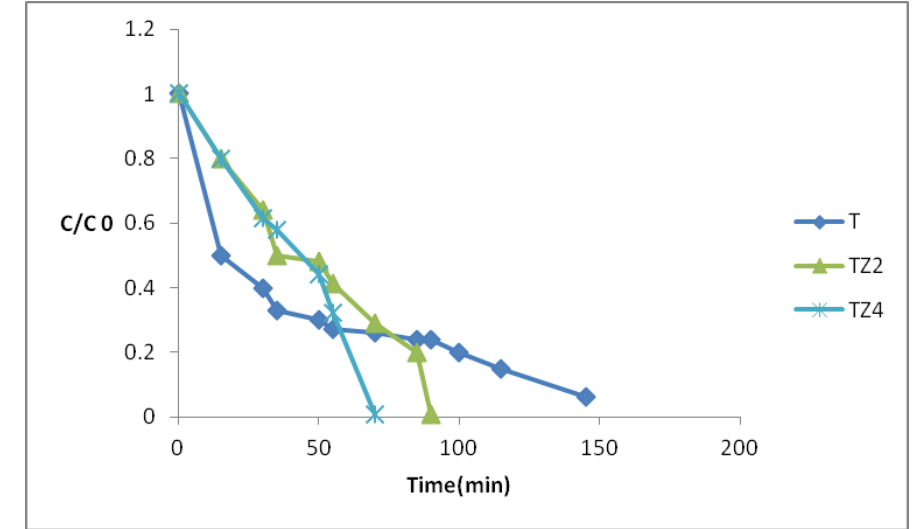
Figure 5. The Photocatalytic activity of powder samples T, TZ2, TZ4.